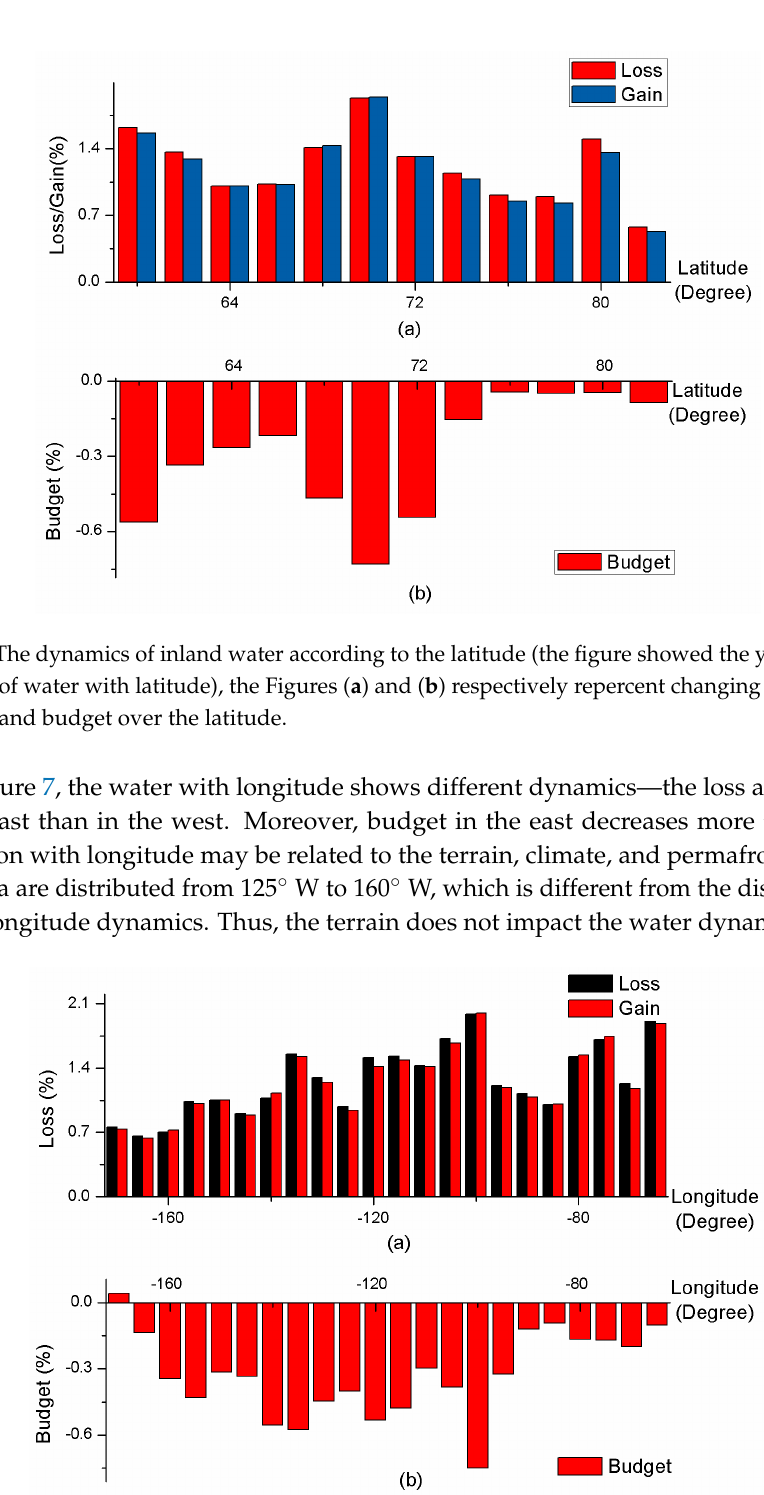
Figure 7. The dynamics of inland water according to the longitude (the figure shows the yearly average water dynamics with longitude), the Figures ( a ) and ( b ) respectively repercent changing percentage of loss/gain and budget over the longitude.